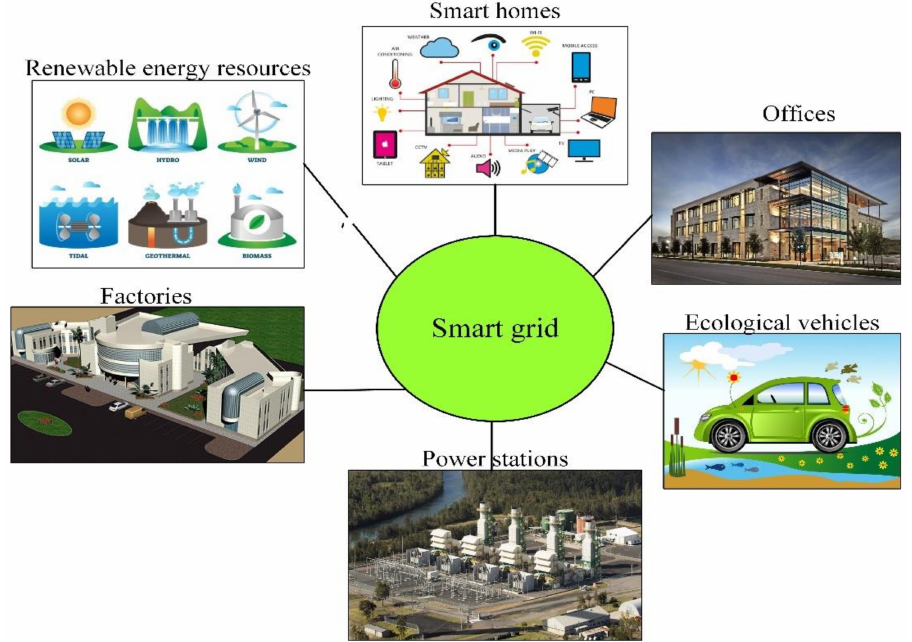
Figure 1. Smart grid